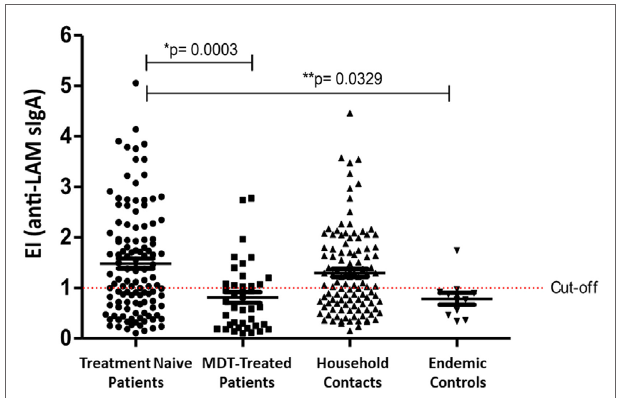
FigUre 1 | Enzyme-linked immunosorbent assay (ELISA) index values of salivary anti-lipoarabinomannan (LAM) sIgA detection in patients at diagnosis, patients at MDT discharge, household contacts, and endemic controls. Cutoff value of ELISA index is ≥ 1. Median comparisons performed with the Kruskal–Wallis test.